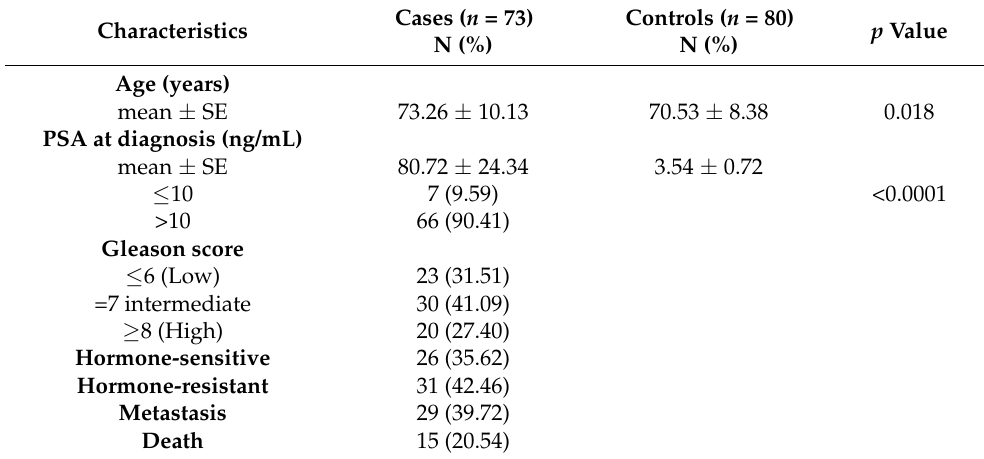
Table 1. Clinicopathologic characteristics of individuals with and without PCa.